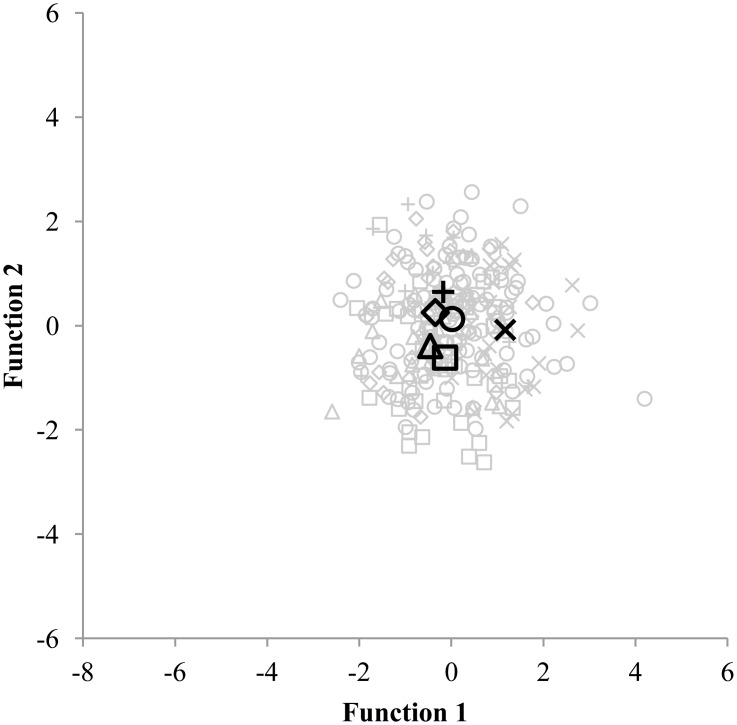
Discriminating between 252 children participating between 1 and 5 hours per week in their sport.Functions at Group Centroids: Ball sports Function 1 = 0.016; Ball sports Function 2 = 0.126; Dance Function 1 = -0.348; Dance Function 2 = 0.250; Gymnastics Function 1 = -0.177: Gymnastics Function 2 = 0.646: Martial arts Function 1 = -0.136; Martial arts Function 2 = -0.615; Racquet sports Function 1 = -0.457; Racquet sports Function 2 = -0.393; Swimming Function 1 = 1.170; Swimming Function 2 = -0.082. Ball sports = ○; Dance = ◆; Gymnastics = +; Martial arts = ☐; Racquet sports = Δ; Swimming = ×.